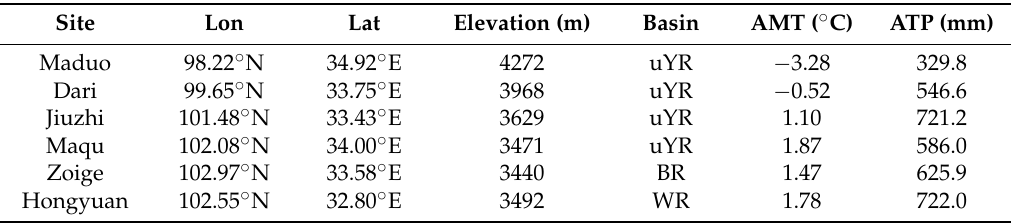
Table 2. Characteristics of the in-situ weather stations used for climate trend detection in the three TP basins. AMT denotes annual mean air temperature, while ATP denotes annual total precipitation. Site Lon Lat Elevation (m) Basin AMT ( ˝ C) ATP (mm) Maduo 98.22 ˝ N 34.92 ˝ E 4272 uYR ´ 3.28 329.8 Dari 99.65 ˝ N 33.75 ˝ E 3968 uYR ´ 0.52 546.6 Jiuzhi 101.48 ˝ N 33.43 ˝ E 3629 721.2 Maqu 102.08 ˝ N 34.00 ˝ E 3471 uYR 1.87 586.0 Zoige 102.97 ˝ N 33.58 ˝ E 3440 BR 1.47 625.9 Hongyuan 102.55 ˝ N 32.80 ˝ E 3492